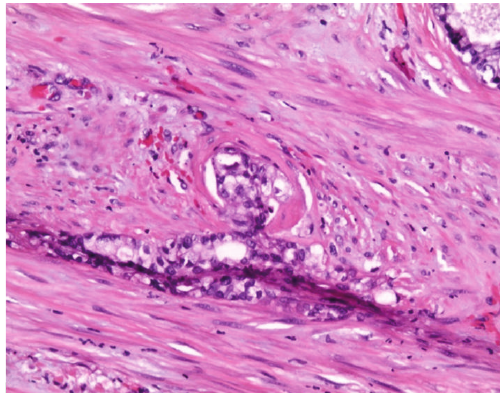
Figure 2: Histologic section of prostatic carcinosarcoma with lym- phovascular and perineural invasion.